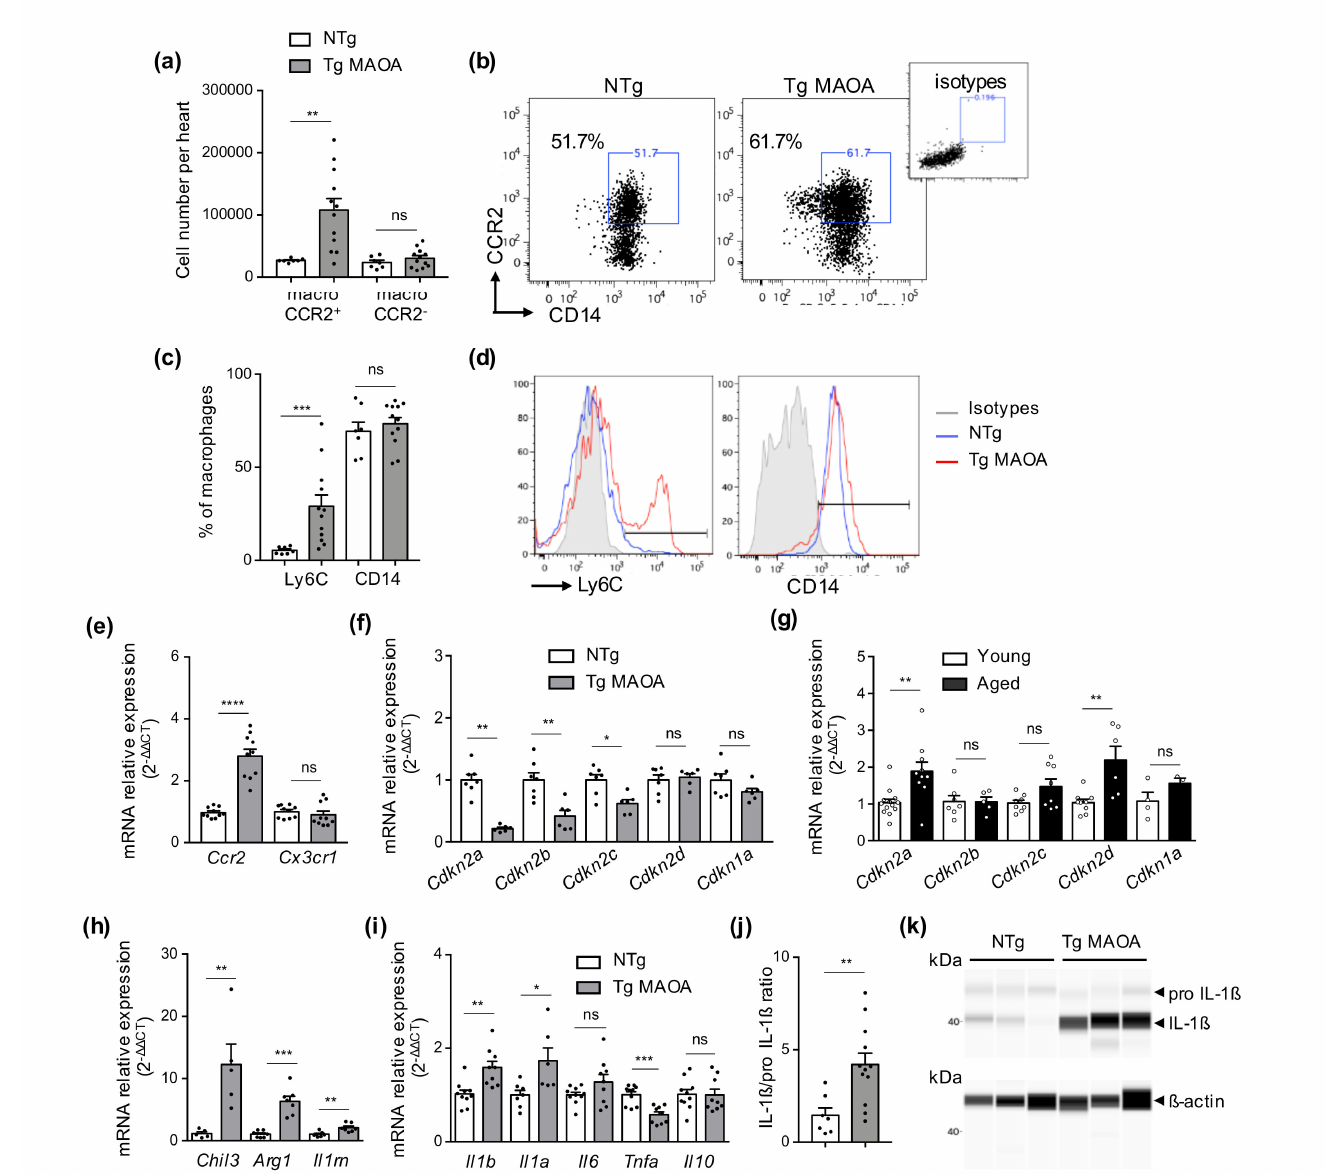
Figure 4. Cardiomyocyte oxidative stress triggers shift in macrophage population phenotype toward a mixed M1/M2 profile. ( a ) Numbers of CCR2 + and CCR2 - macrophages in ventricles of NTg ( n = 7) and Tg MAOA mice ( n = 12). ( b ) Representative dot-plots of CCR2 and CD14 expression by cardiac macrophages of NTg and Tg MAOA mice determined by flow cytometry. Control staining of viable macrophages with isotypes is shown. ( c , d ) Percentage of cardiac macrophages positive for Ly6C and CD14 of NTg ( n = 7) and Tg MAOA ( n = 12) mice ( c ) and representative histograms ( d ) by flow cytometry. ( e ) Relative mRNA expression of chemokine receptors, Ccr2 and Cx3cr1 by cardiac macrophages isolated from Tg MAOA ( n = 10) compared to NTg ( n = 10) mice. ( f , g ) Relative mRNA expression of CDKIs by cardiac macrophages isolated from Tg MAOA ( n = 7) compared to NTg ( n = 6) mice ( f ) or from 20 month-old mice ( n = 7 – 9) compared to young ( n = 5 – 9) mice ( g ). ( h , i ) Relative mRNA expression of M2 markers ( n = 5 – 7 mice per group) ( h ) and of M1/M2 cytokines ( n = 9 – 10 mice per group) ( i ) by cardiac macrophages isolated from Tg MAOA compared to NTg mice. ( j , k ) Quantification ( j ) of protein expression of IL-1 β relative to pro IL-1 β by cardiac macrophages isolated from NTg ( n = 7) and Tg MAOA ( n = 10) mice and representative images ( k ) of cell lysate samples immunoblotted with anti IL-1 β (upper panel) or with anti β -actin (lower panel) by capillary-based western blot ( n = 3 mice per group). Data are expressed as means ± SEM. * p < 0.05, ** p < 0.01, *** p < 0.001, **** p < 0.0001 vs. NTg groupe or ( f ) vs. young